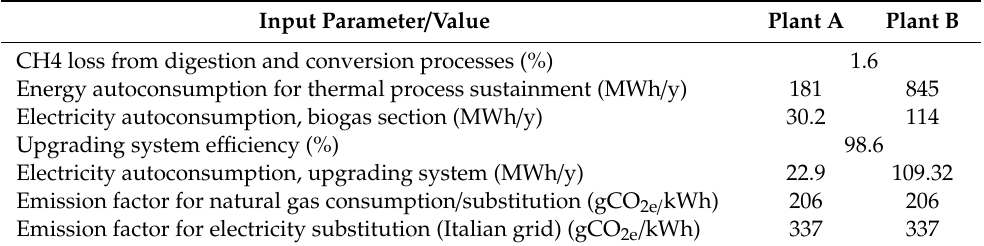
Table 3. Input values and parameters implemented in the MCBioCH4 model.